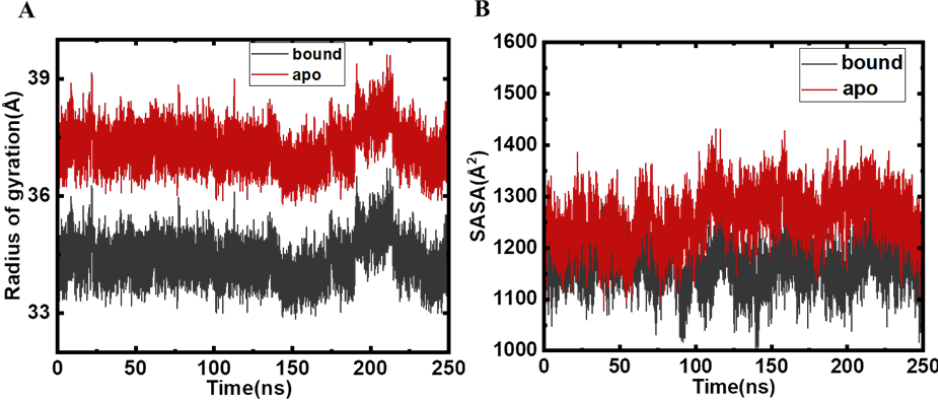
Figure 4. ( A ) R g plotted during the 250 ns MD run of apo (red) and Mtf-bound MARK4 (black). ( B ) SASA plot of protein backbone atoms as a function of number of frames in the production runs.